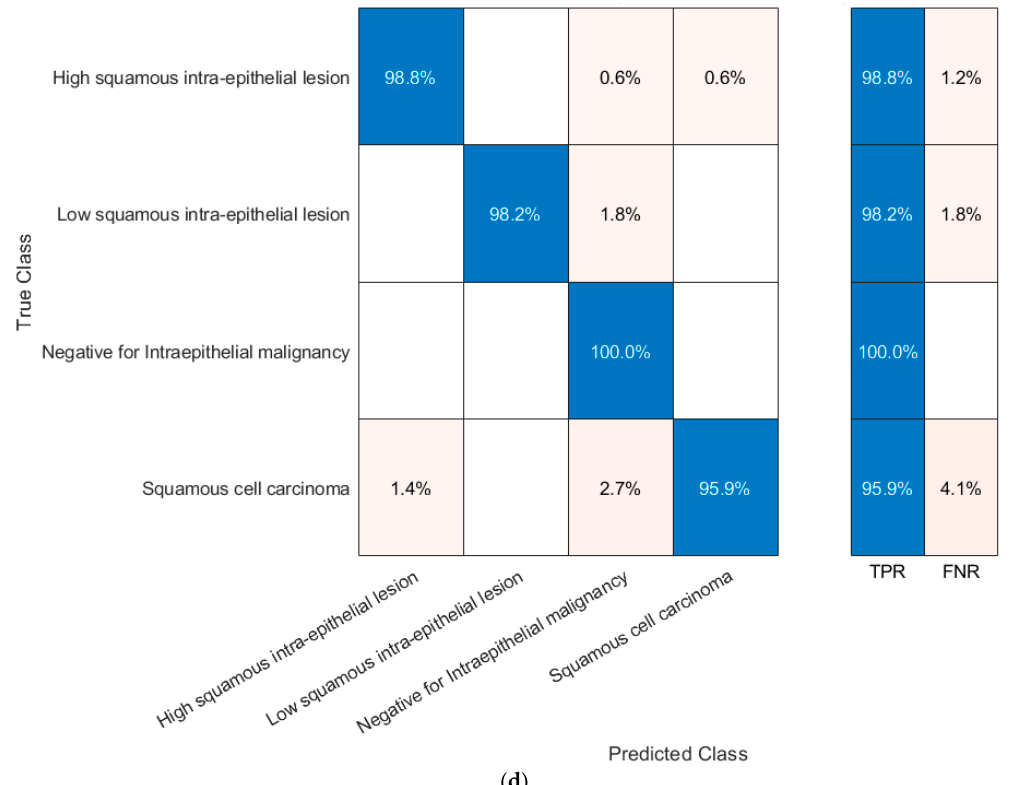
Figure 3. Confusion Metrics for SVMs with different kernels constructed with PCs generated after fusing the entire DL features with the combined handcrafted features; ( a ) linear kernel, ( b ) quadratic kernel, ( c ) cubic kernel, and ( d ) gaussian kernel.